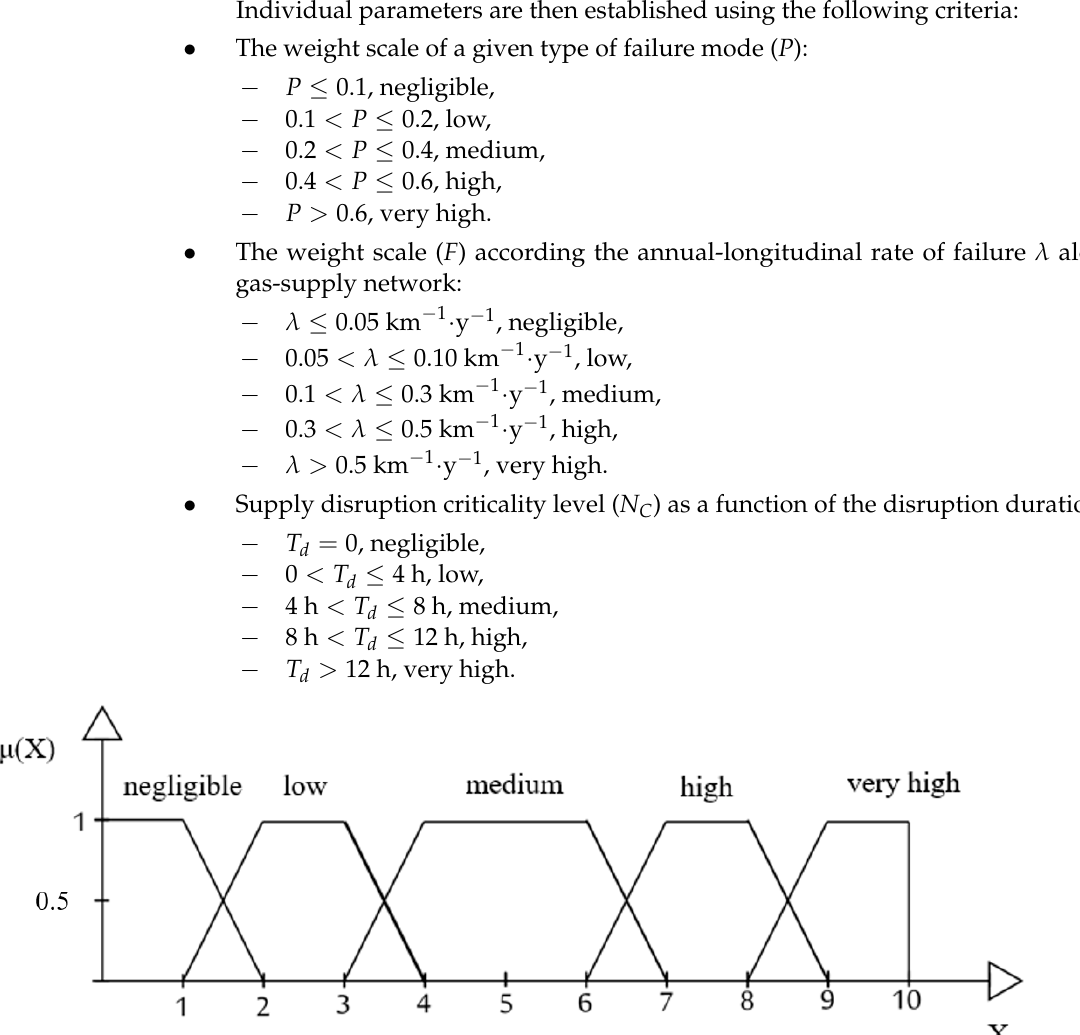
Figure 1. Parameters P , F and N C membership function.